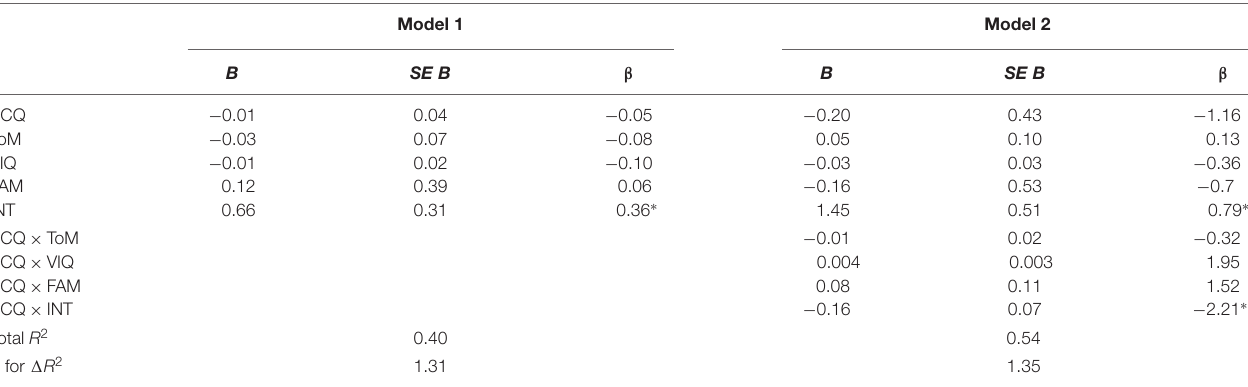
TABLE 5 | Hierarchical multiple regression predicting object substitution subtype of pretend